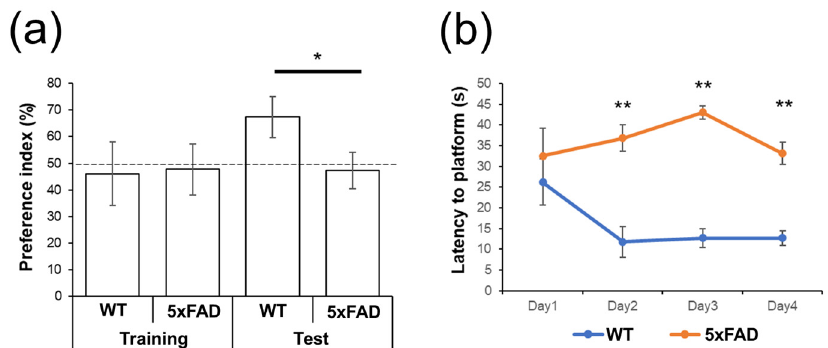
Figure 3. ( a ) Result of novel object recognition test in training and test phases; ( b ) result of Morris water maze as the day passes. All data show means ± standard error of the mean. The significance of differences between the groups was determined using the paired Student’s t -test. All values of p less than 0.05 and 0.005 were considered to be statistically significant and indicated using ‘*’ and ‘**’, respectively.